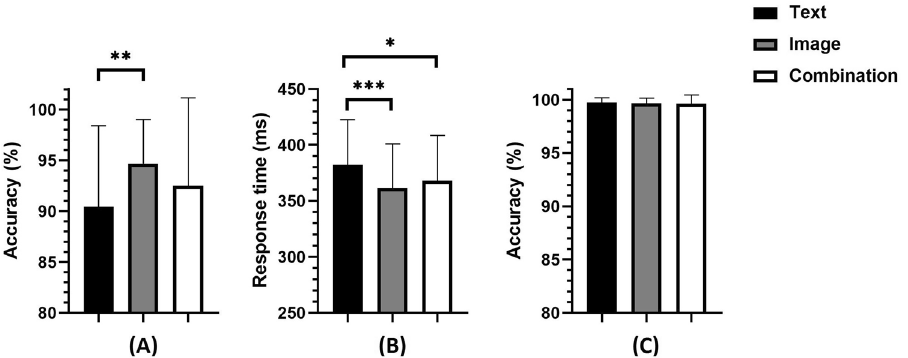
Figure 6. Accuracy and response time in the Go/No-go task: ( A ) accuracy for target; ( B ) response time of target; ( C ) accuracy for nontarget. * p < 0.05; ** p < 0.01; *** p < 0.001.